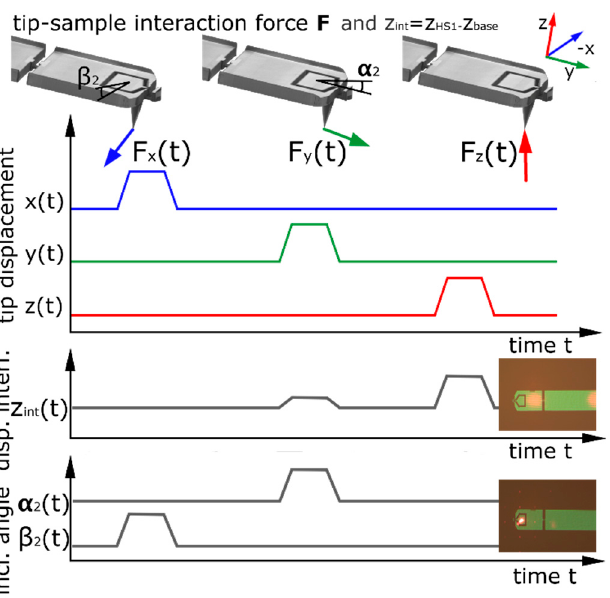
Figure 4. Detection principle of the tip–sample interaction of the 3D-Nanoprobe with the interferometer focused on HS1 and the dual-optical lever focused on HS2.